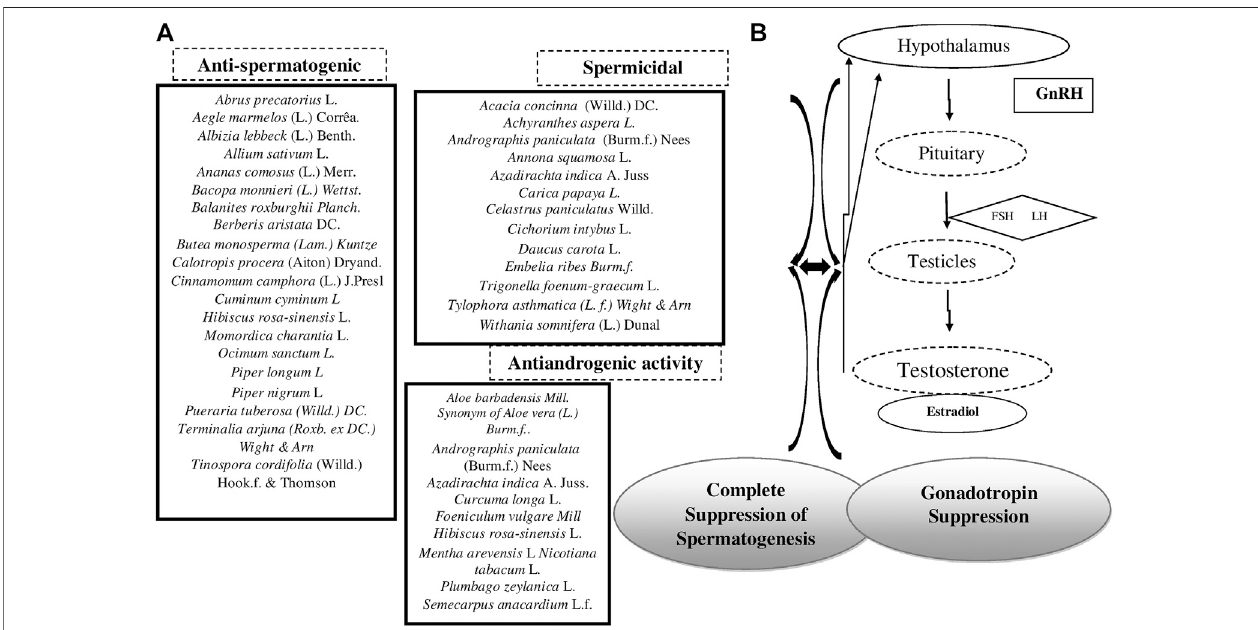
FIGURE 5 | Male contraceptive plants and possible